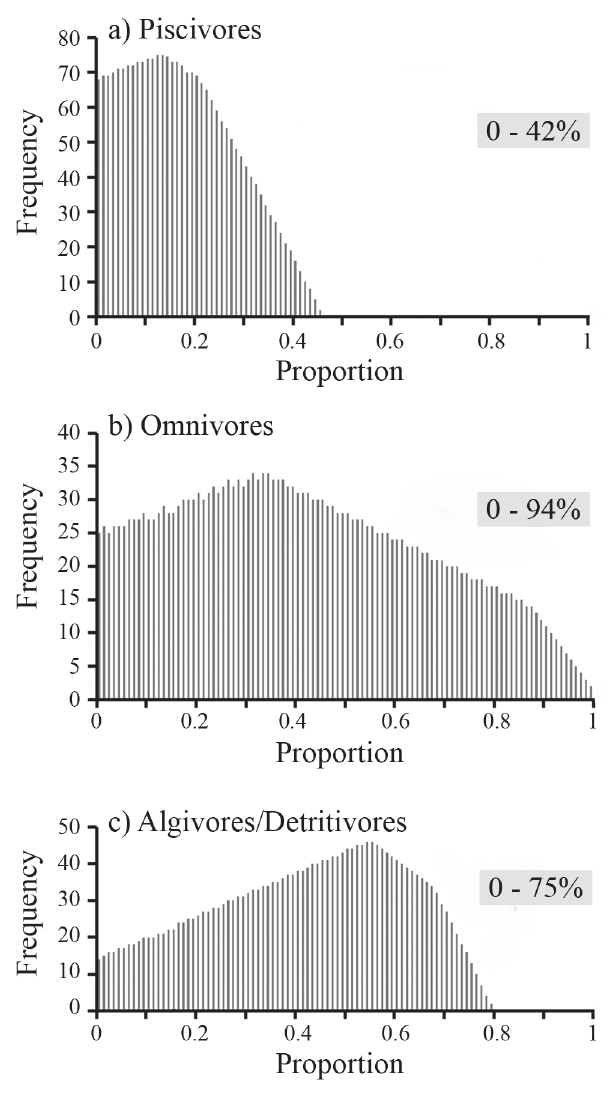
Fig. 3. Histograms of the distribution of all feasible contributions of the three dietary fish groups for Arapaima : a ) piscivores, b ) omnivores, and c ) algivores/detritivores based on the IsoSource model. Values in boxes are 1% percentile and 99% percentile ranges for these